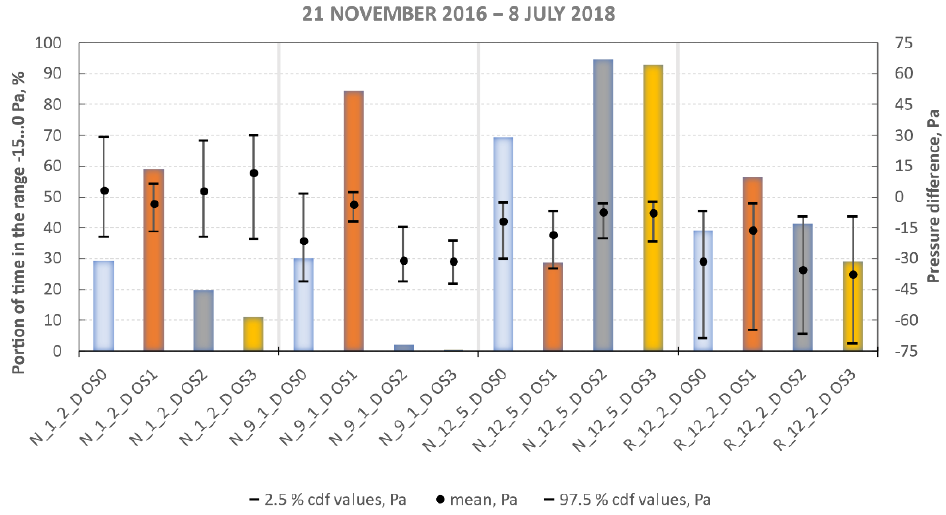
Figure 6. Example of air pressure difference conditions varying between different operating situations in four buildings. The vertical bars describe the relative portion of time that the air pressure difference was between − 15 Pa and 0 Pa (left y-axis). The dot (mean) and whiskers (2.5% and 97.5% cdf values) describe the air pressure difference values (right y-axis).